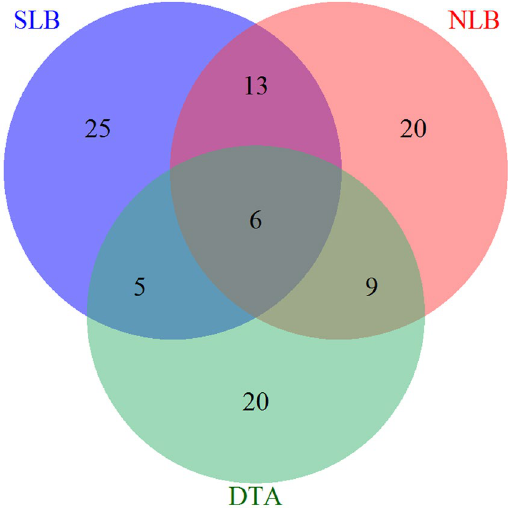
Figure 2. Number of quantitative trait loci (QTLs) shared among SLB and NLB resistance and the days to anthesis (DTA).